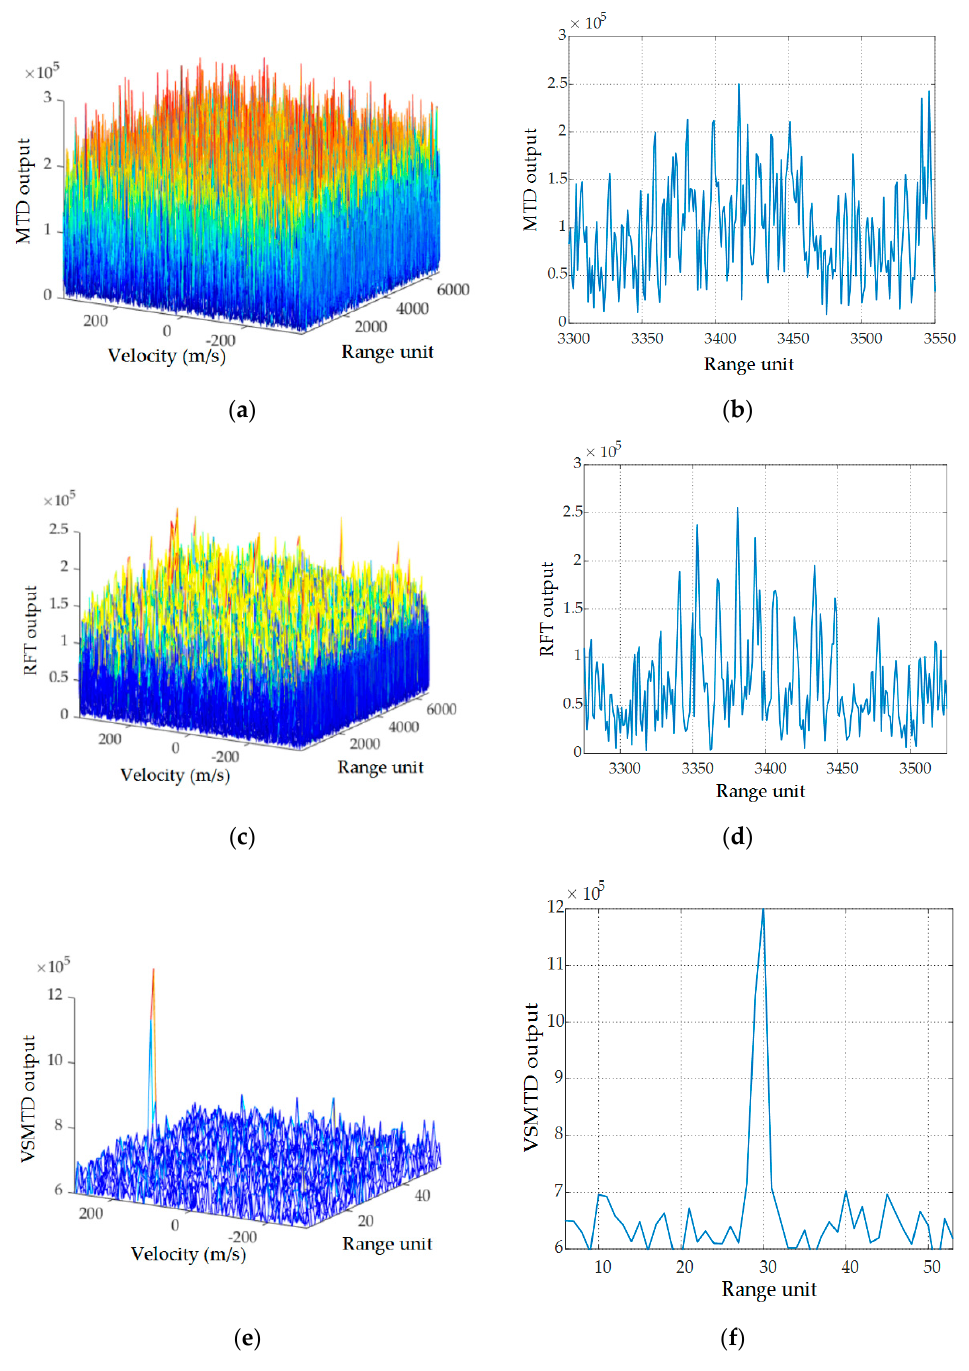
Figure 18. ( a ) MTD result with SNR = − 5 dB; ( b ) Range profile of MTD result; ( c ) RFT result with SNR = − 5 dB; ( d ) Range profile of RFT result; ( e ) VSMTD result with SNR = − 5 dB; and ( f ) Range profile of VSMTD result.